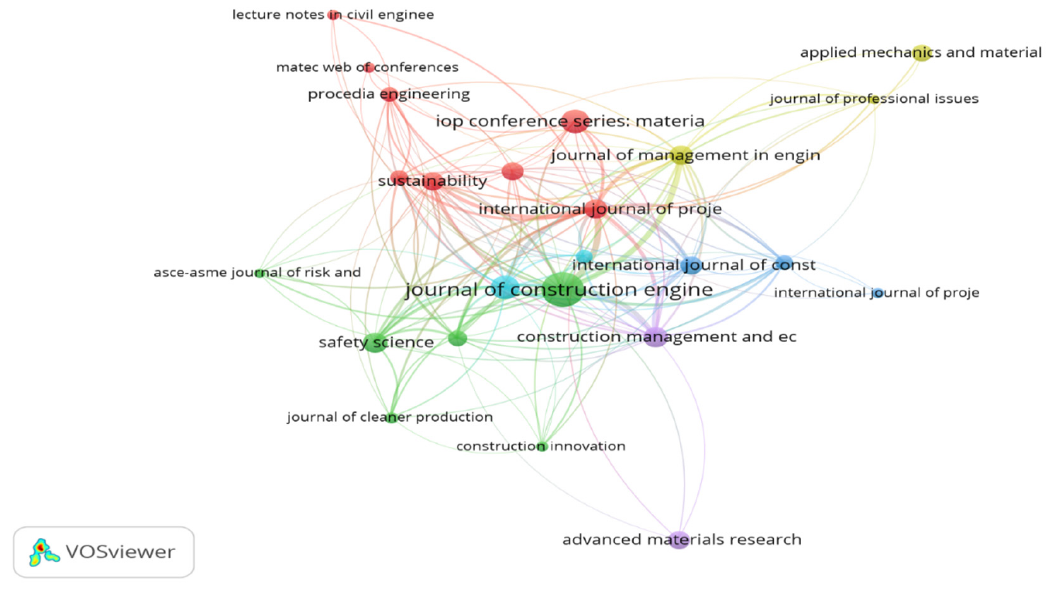
Figure 6. Outlets of risk management in construction research.